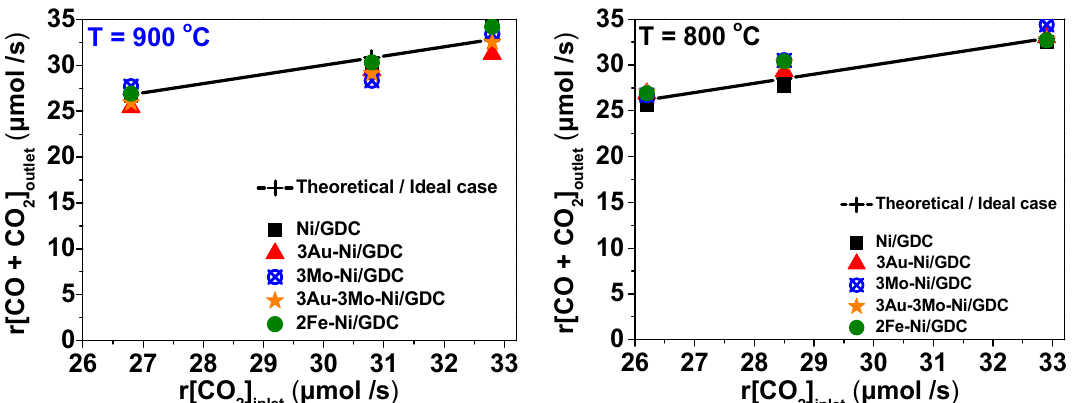
Figure 8. Investigation of the Boudouard reaction at 900 °C and 800 °C under OCP conditions on ESCs comprising: Ni/GDC, 3Au-Ni/GDC, 3Mo-Ni/GDC, 3Au–3Mo-Ni/GDC, and 2Fe-Ni/GDC. Theoretical